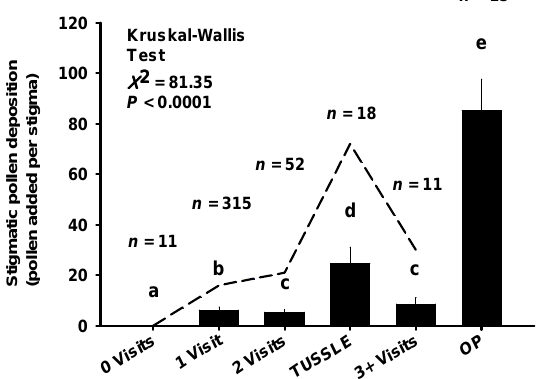
F IGURE 2. Net stigmatic pollen loads transferred to three species of Hibiscus . Flowers after tussles between 2 bees, no visits, single visits, double visits, triple, or near-simultaneous visits, and open pollination (OP) by Ptilothrix bombiformis . Black bars represent mean stigmatic pollen deposition including 1±SE. Sample sizes are shown above bars and mean differences denoted by different letters according to multiple Wilcoxon 2-sample exact tests. The dashed line above the first 4 bars indicates the percentage of visits that transferred 10+ pollen grains onto Hibiscus stigmas (“contact visits”).